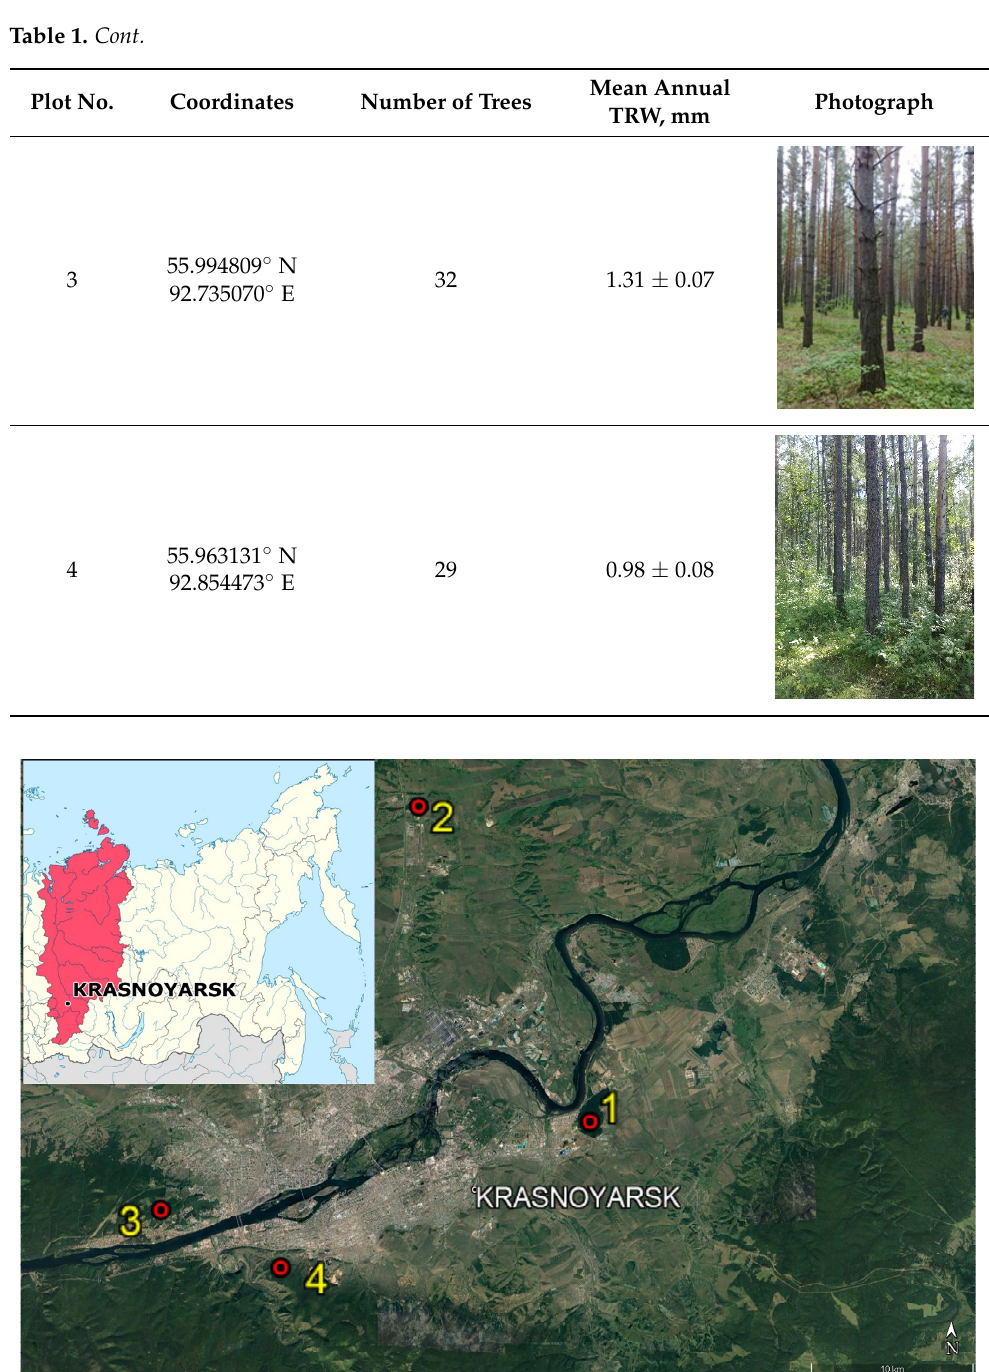
Figure 1. Positions of sample plots No. 1–4 around the city of Krasnoyarsk. For the variables analyzed over the time interval selected in this study, no strong trend of the NDVI and LST data was observed, but there was a temporal trend of TRW. A typical TRW time series with trend is shown in Figure 2 (curve 1).